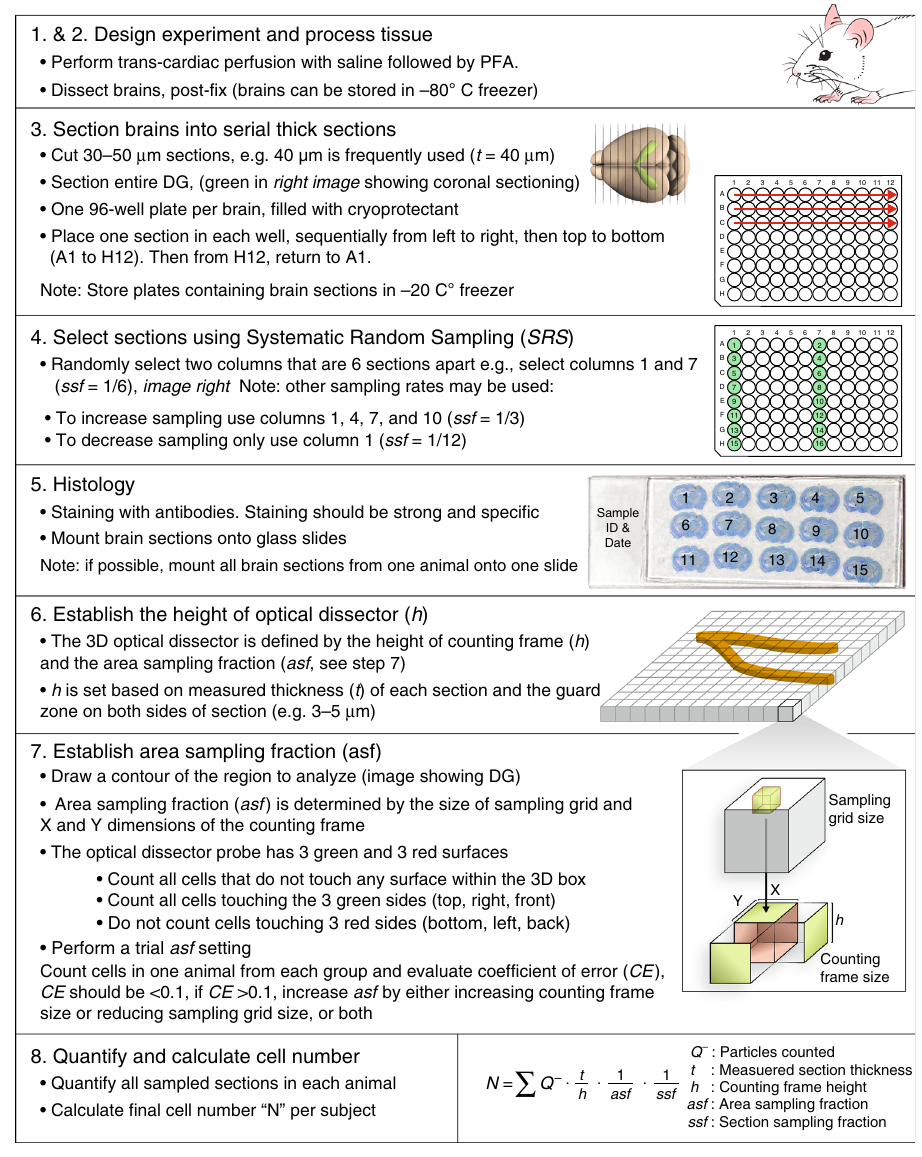
Fig. 3 Design-based stereology work fl ow for quantitative analysis of adult neurogenesis. Optimal results of experiments can be obtained by following these steps: 1. Experimental design. 2. Tissue processing for optimal histological analysis. 3. Sectioning into thick (e.g., 40 μ m) sequential sections and store in long-term tissue storage reagent (e.g. cryoprotectant). 4. Selection of representative sections using systematic random sampling (SRS). 5. Histological staining of the tissue with appropriate antibodies for cell types of interest. 6. Establishing the height of counting frame for optical fractionator (h). 7. Establishing the area sampling fraction (asf) to de fi ne the fraction of the specimen that will be quanti fi ed to represent the entire specimen. This is done by setting the sampling grid and de fi ning the size of the counting frame (X and Y dimensions) for optical fractionator. 8. Quanti fi cation of sampled regions using optical fractionator and calculation of total numbers of markers in the specimen using the parameters set above and the number of cells